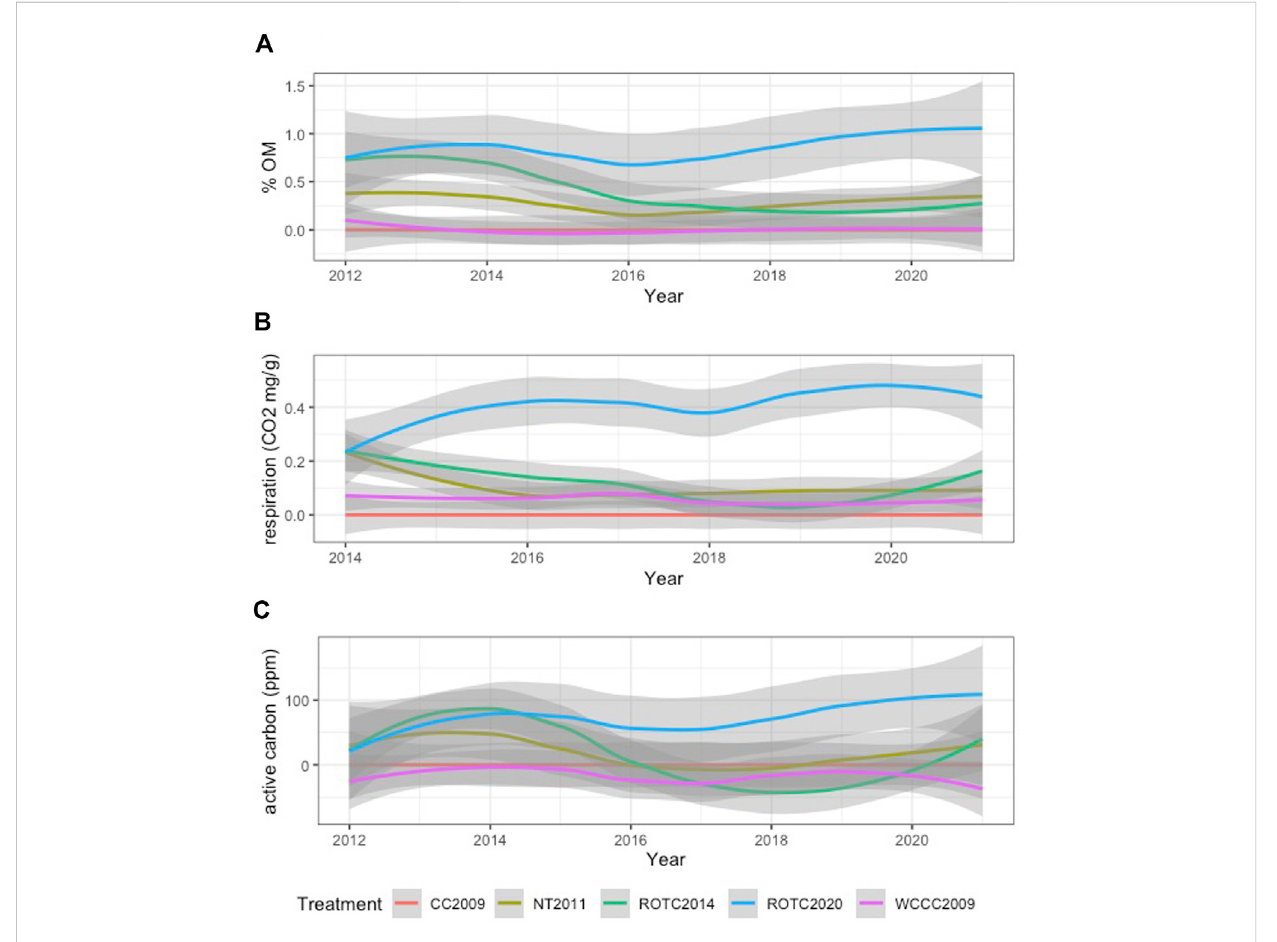
FIGURE 3 Loessplots(locallyweightedsmoothing)showdeviationinsoilbiologicalparametersfromcontinuouscornbytreatmentfrom2012to2021: (A) Soil organic matter content (B) Respiration (C) Active